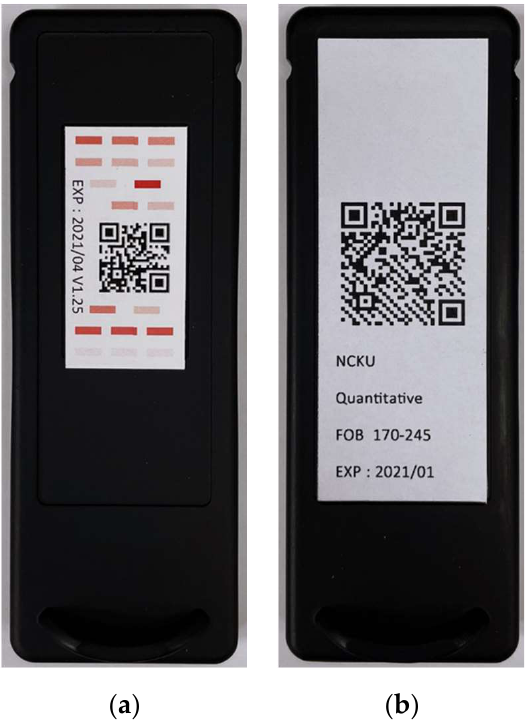
Figure 5. ( a ) The calibration cassette, and ( b ) the QR Code cassette. The colors of the C and T lines for the actual rapid tests were derived from colloidal gold. The coloration changes with the concentration of the colloidal gold nanoparticles in the captured target. Since the color of the colloidal gold ranges between purple and red, self-made simulated color strips close in appearance to the actual test strips were used as the measurement targets. When quantifying the color rendering response through the program analysis, the RGB distribution of an actual immune test strip in the primary colors is close to red. Therefore, the R-values in the three primary RGB colors were fixed, and the values of G and B were changed to design the tests with different color scale values ranging from 125 to 255. These values closely mimic the color changes in real rapid tests. The results obtained by testing the self-made simulated rapid test strips with the rapid test system (see Figure 6) are shown in Figure 7. Figure 7 shows that the de- tected grayscale values correspond to the printed rapid test strips with real grayscale. It can be seen that the rapid test system has good linearity, and the coefficients of variation (CV) are below 0.4%. The R square value is 0.997. The image analysis program had good linearity for the measurement of different color levels.